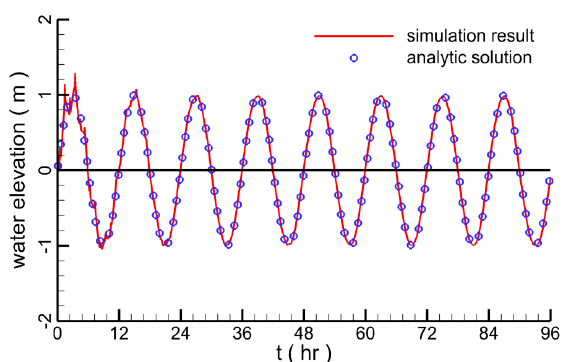
Figure 10. The free surface elevation comparison between numerical result and analytical solution.